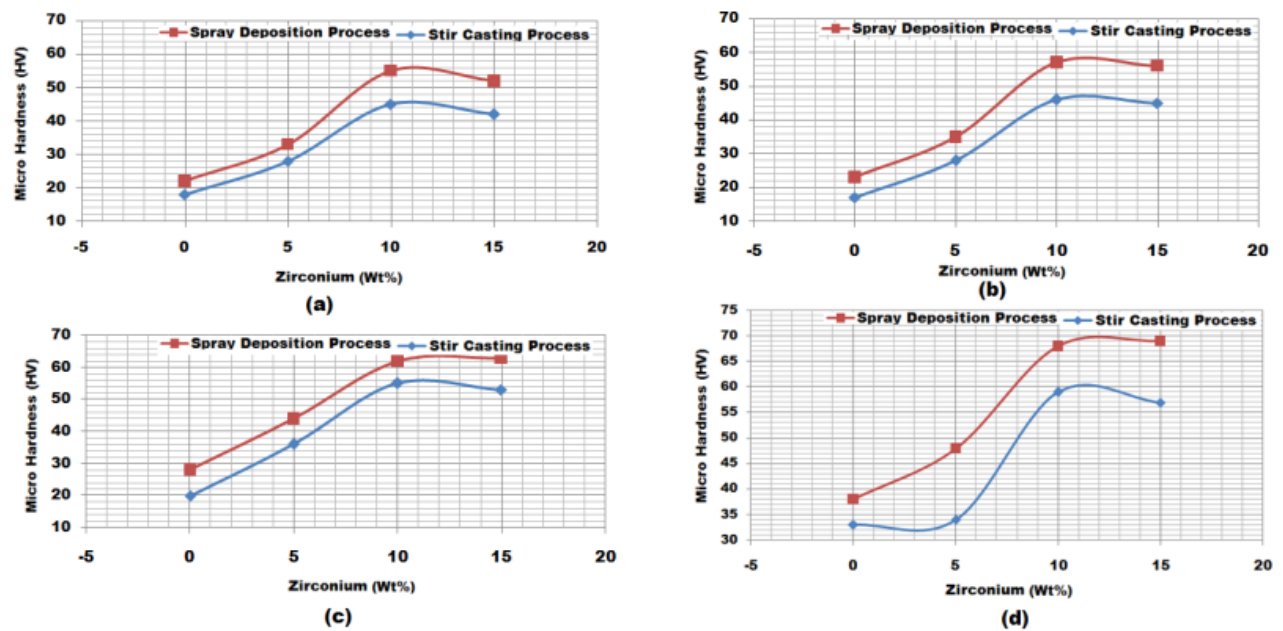
Figure 9. Micro hardness (0.05% error) experimental graph at different processing techniques of Si-Al alloy matrix reinforced with ZrO 2 particulates for ( a ) 10% ( b ) 11% ( c ) 12% ( d ) 13 wt.% of silicon.